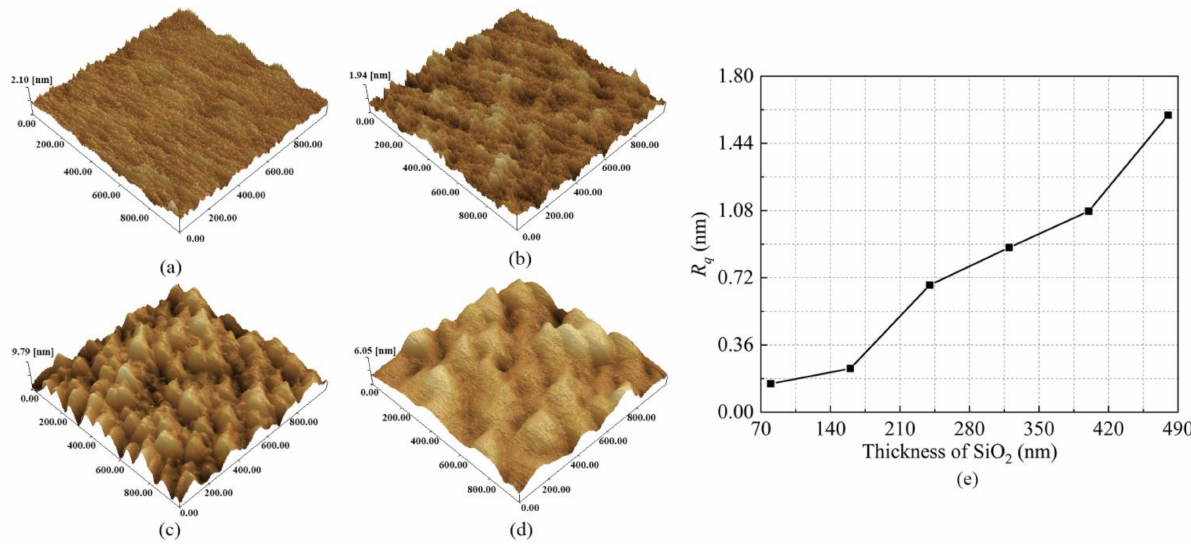
Figure 6. Roughness of the SiO 2 films of different thicknesses: ( a ) 80, ( b ) 160, ( c ) 240, and ( d ) 320 nm. ( e ) Surface roughness with different SiO 2